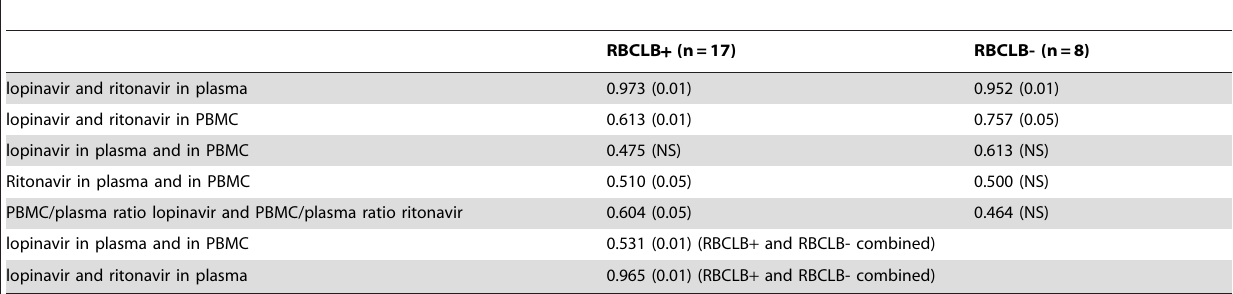
Table 4. Correlations between plasma and intracellular levels, and correlations between the concentrations of the two drugs in HIV-1 infected